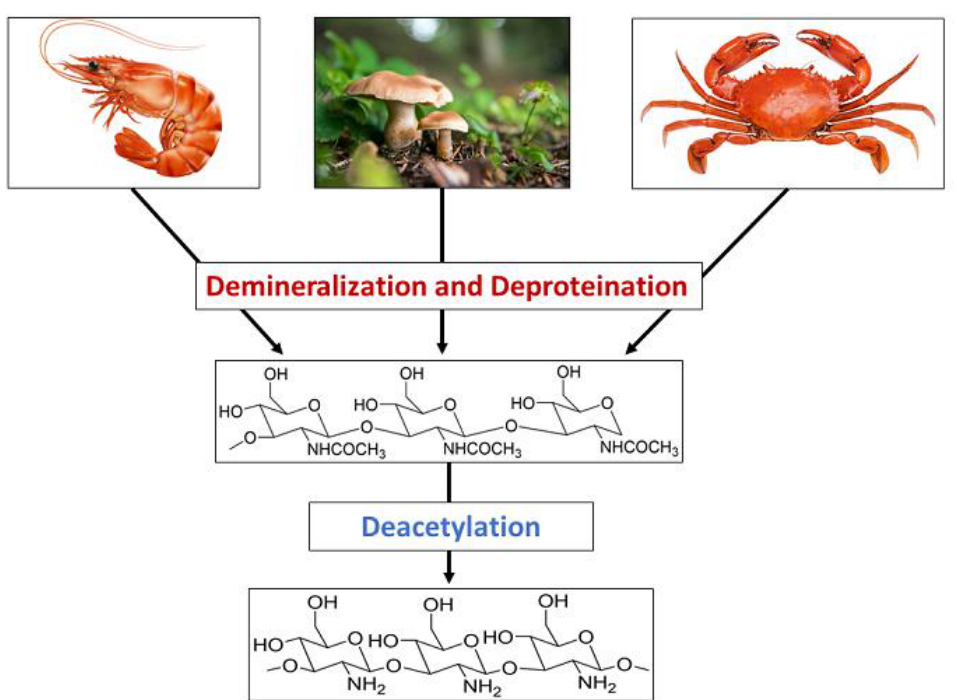
Scheme 1. Synthesis of chitosan bio polymer using chitin presenting natural sources.